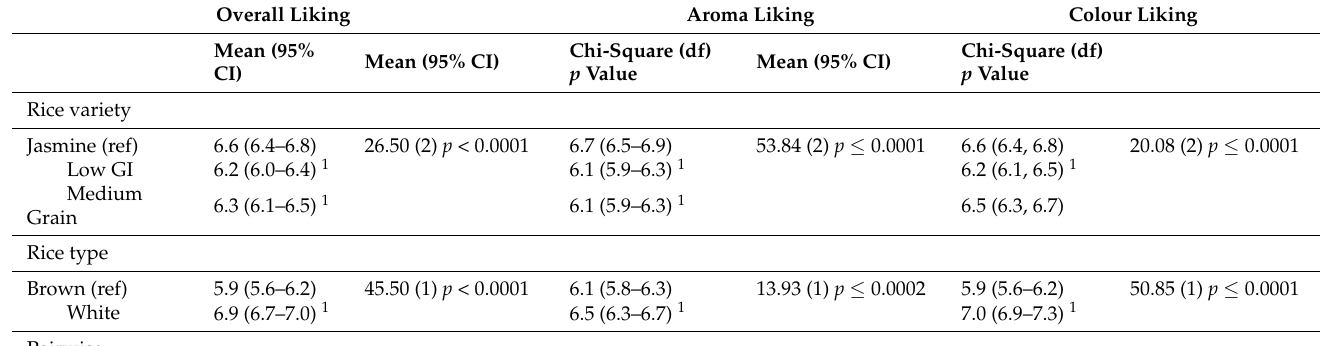
Table 3. Linear mix model (repeated measures) ANOVA table for brown and white rice varieties before tasting. Overall Liking Aroma